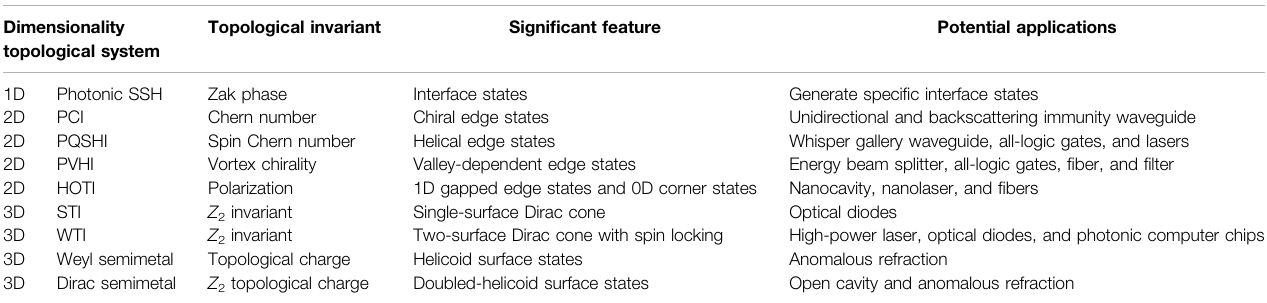
TABLE 1 | Summary of various all-dielectric photonic topological systems mentioned in this review. Dimensionality topological